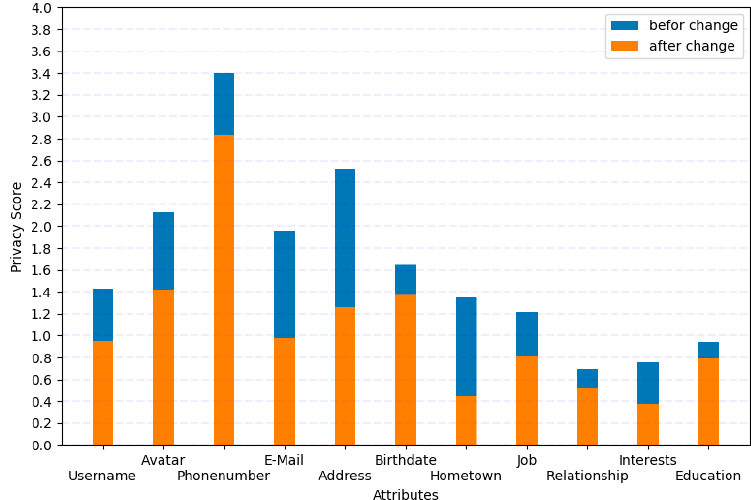
Table 8. Profile change.